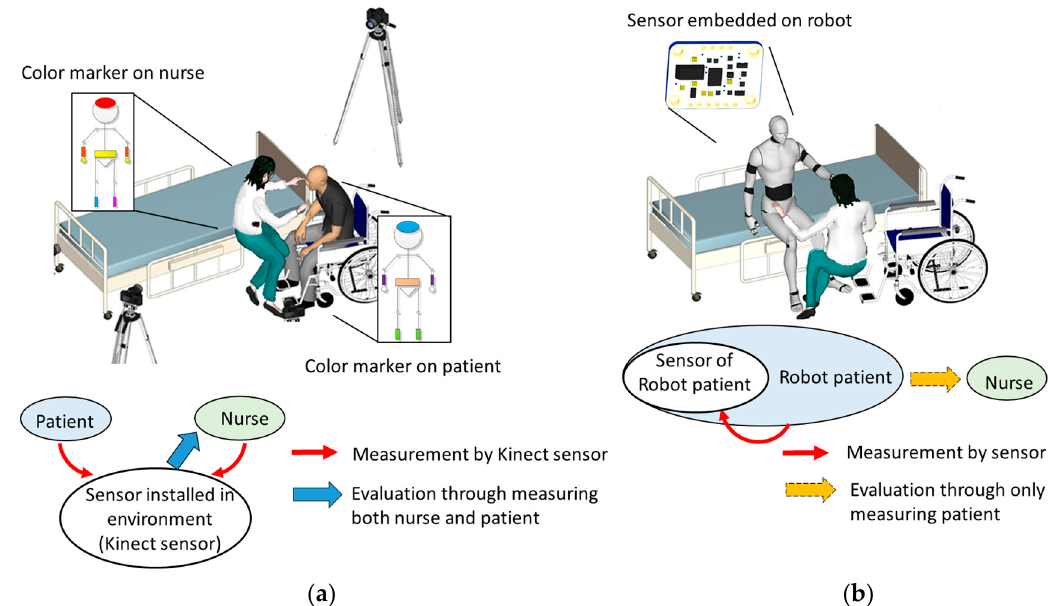
Figure 1. Evaluation system of transfer skill ( a ) our previous work ( b ) final goal.